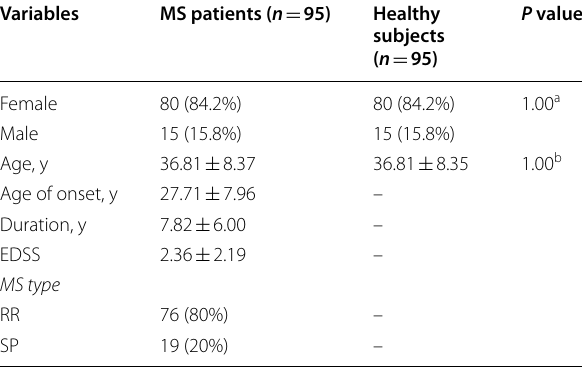
Table 2 Demographic and clinical characteristic of healthy controls and